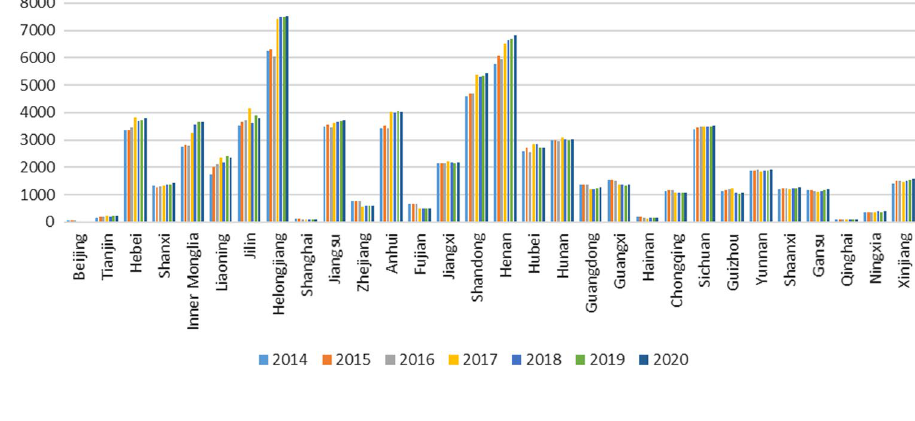
Fig. 5 2014–2020 GDP in dif- ferent regions of